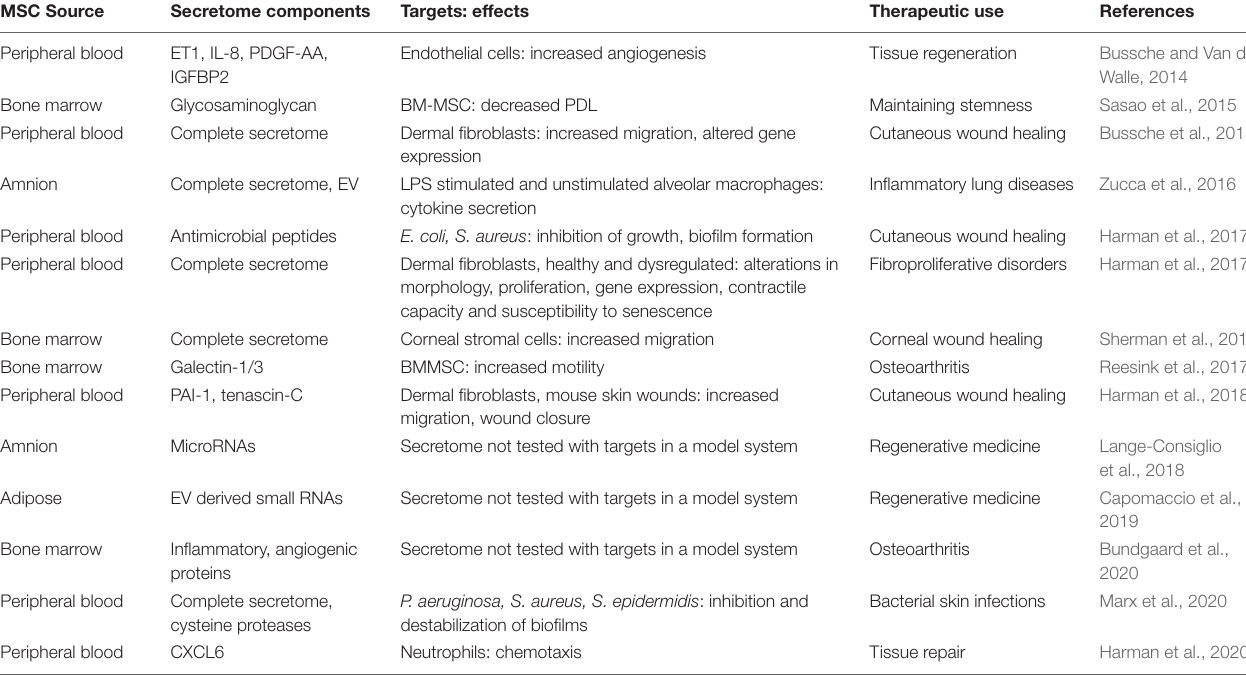
TABLE 6 | Horse MSC secretome components, targets, effects, and potential therapeutic